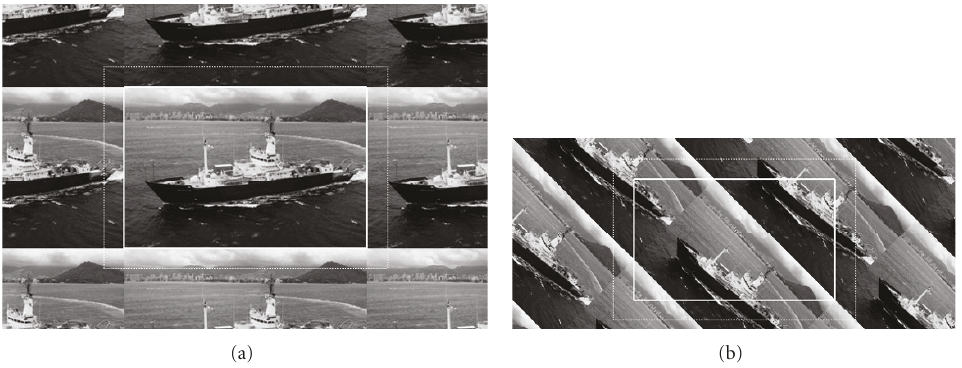
Figure 7: Boat image of size 200 × 300 (a) periodic extension of the original image and (b) after downsample by Q 0 .